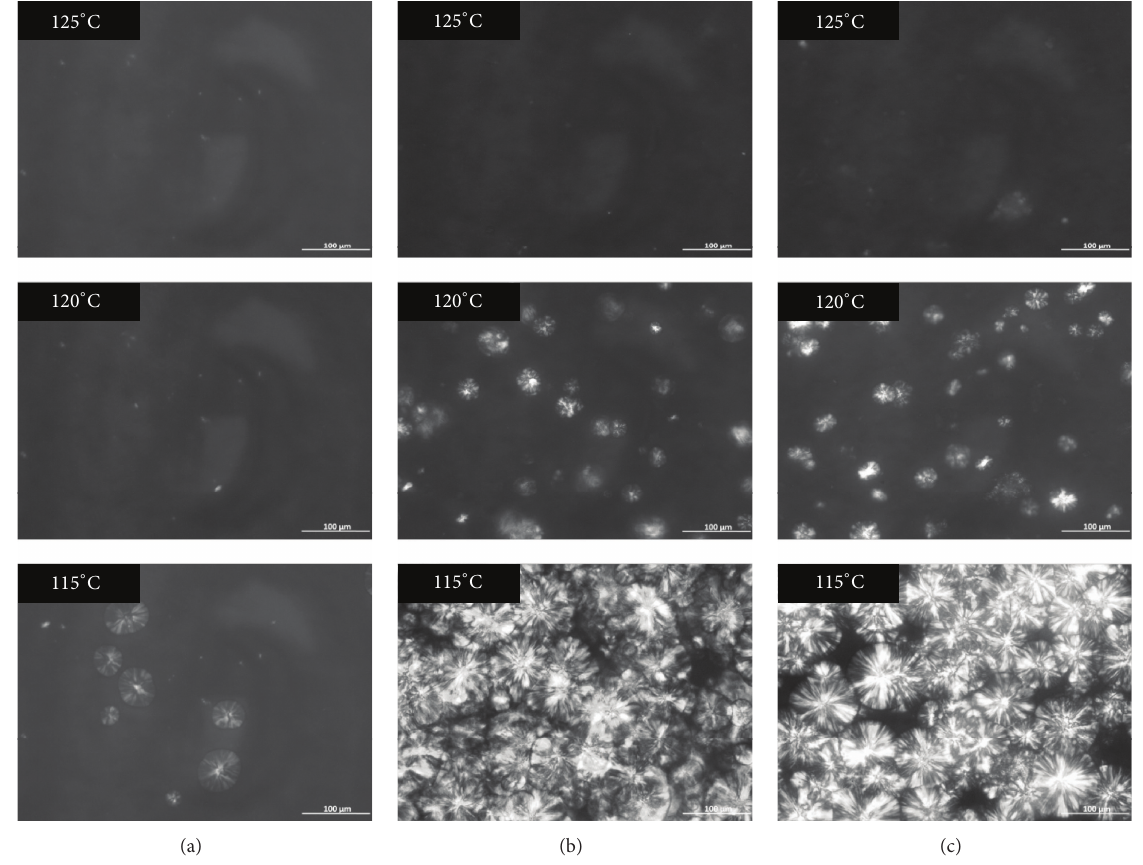
Figure 6: Optical micrographs of crystallization process of (a) neat PP, (b) PP/Oil-g-CF composite, and (c) PP/Silane-g-CF composite (scale bar 100 𝜇 m).